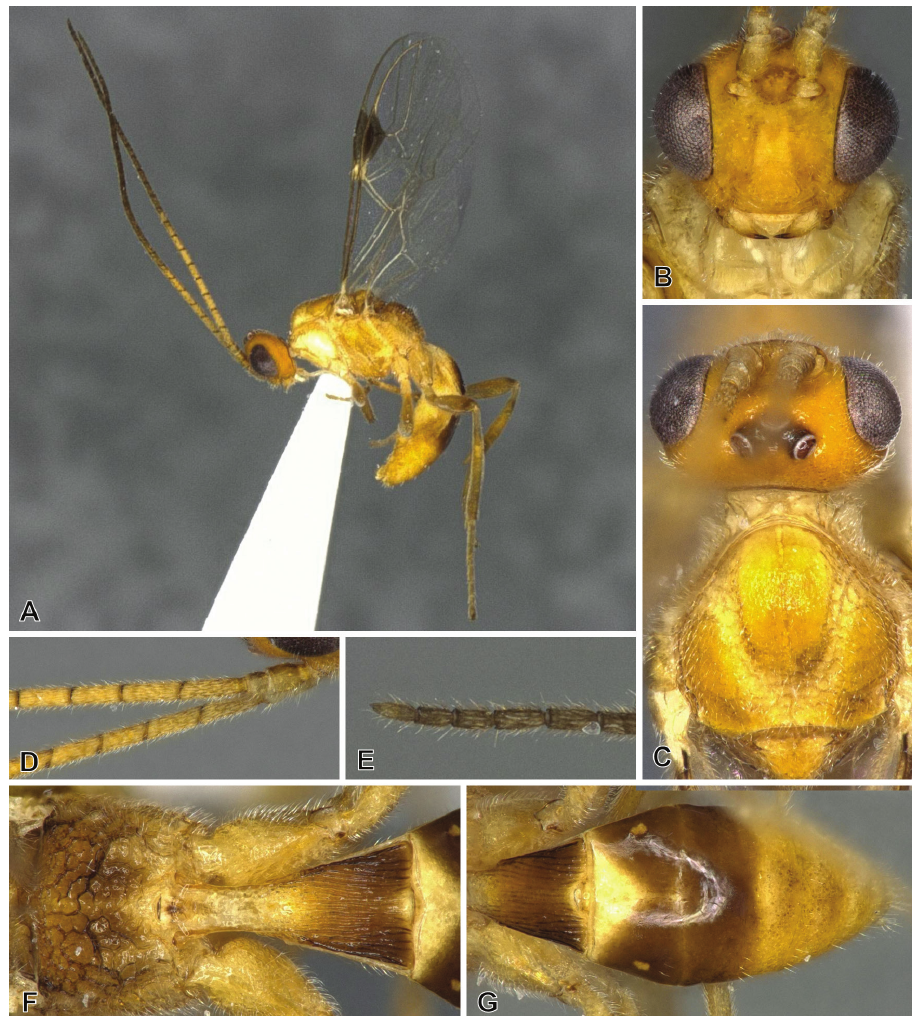
Figure 3. Meteorus stellatus sp. nov., ♂ paratype A habitus B head, frontal view C head and mesonotum, dorsal view D basal antennal segments E apical antennal segments F propodeum and T1, dorsal view G T2 and following tergites, dorsal